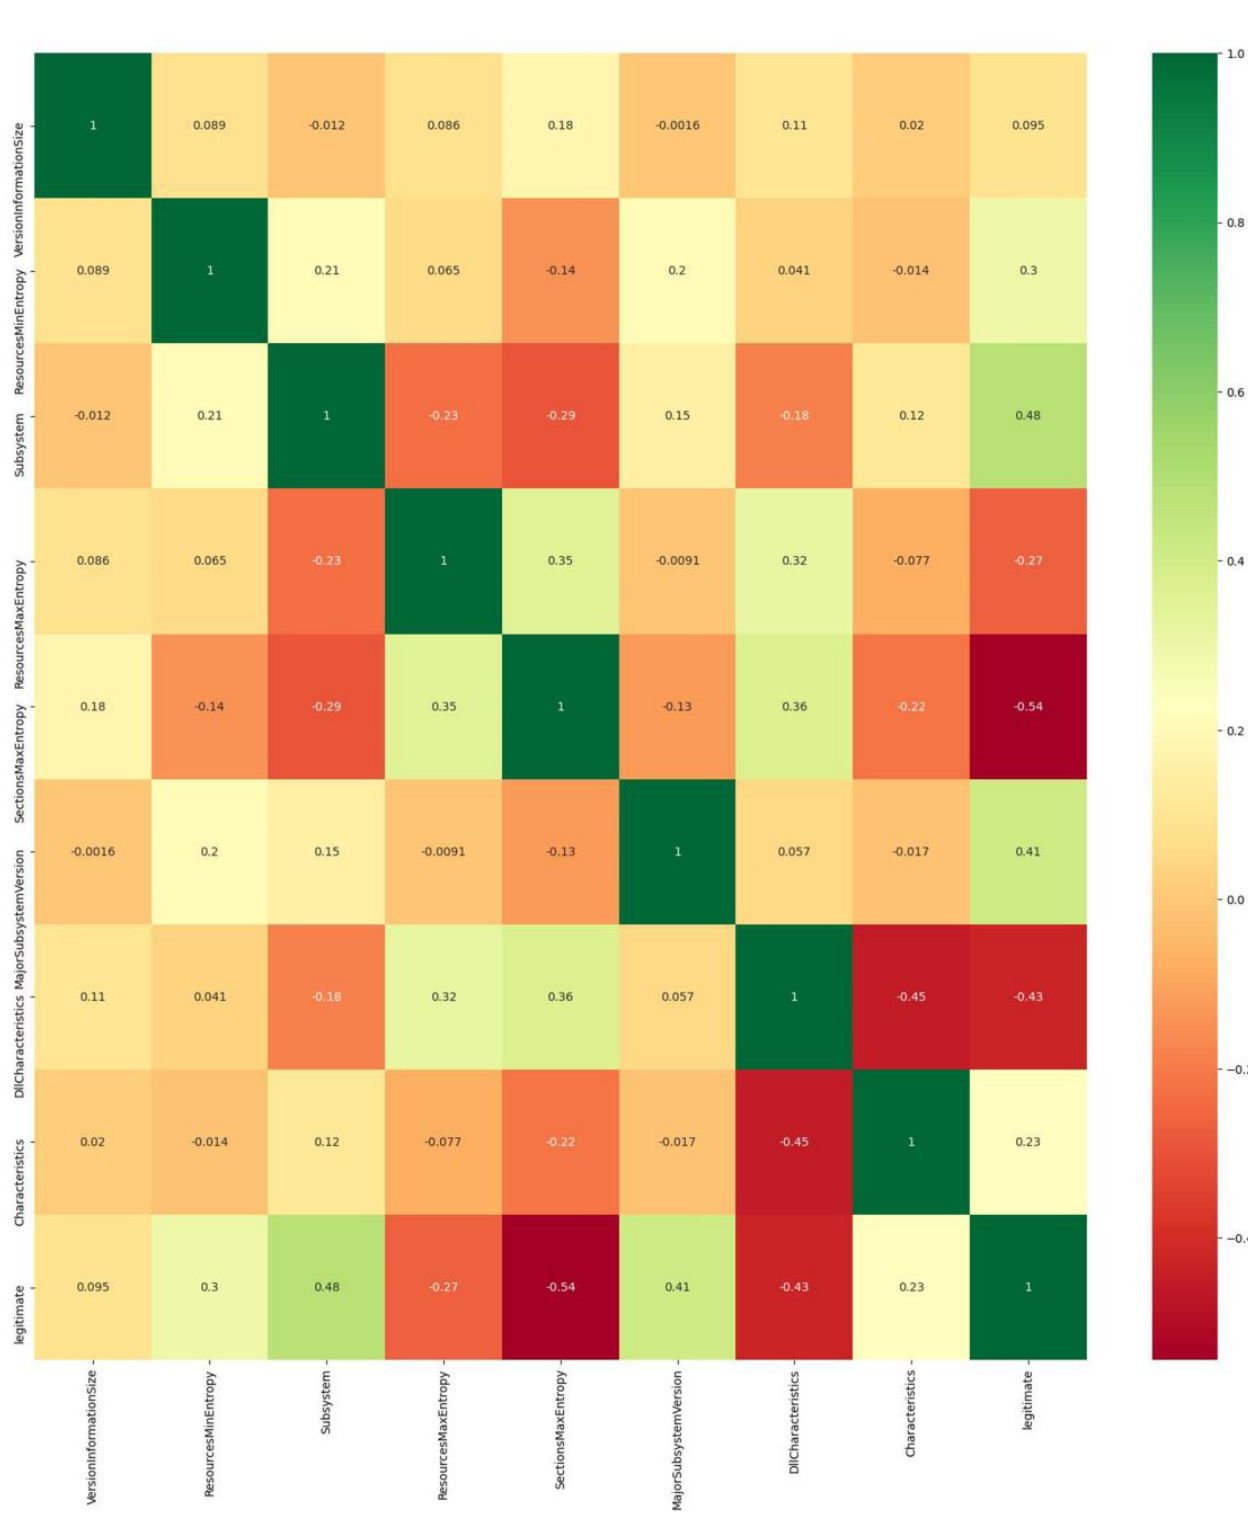
Figure 3. Correlation matrix of the final selection of features from the initial dataset.